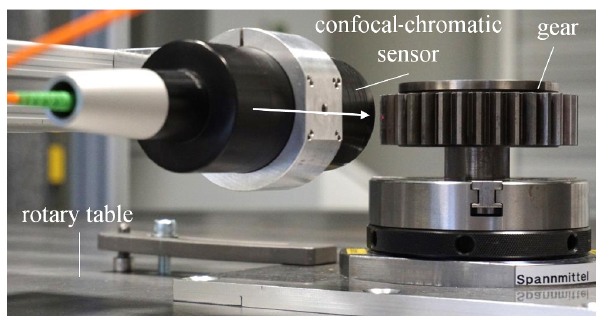
Figure 3. Experimental setup of a multi-distance measurement of the mean base circle radius of a spur gear.